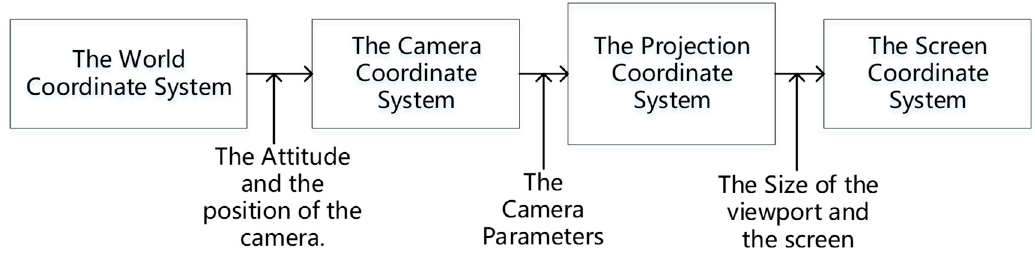
Figure 2. The conversion process between the world coordinate system and the screen coordinate system.